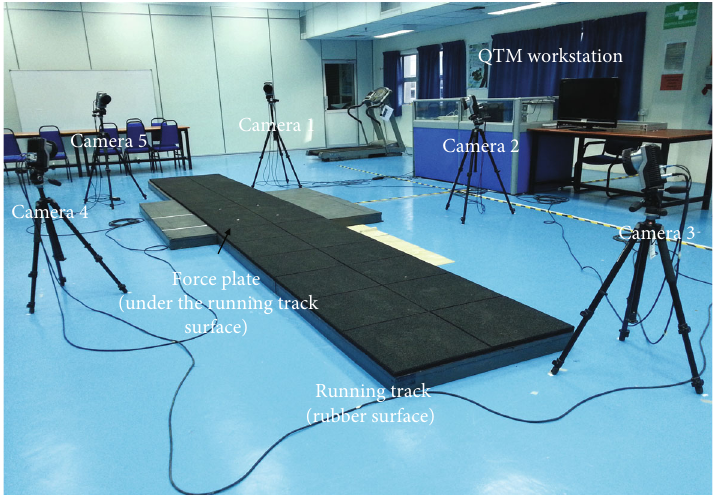
Figure 1: Layout of the experiment.